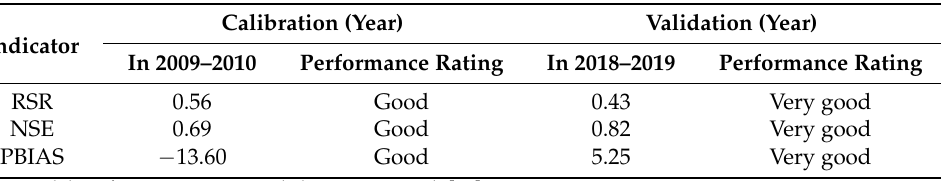
Table 14. Performance of the SWAT model for water yield estimation in calibration and validation periods under the dry year